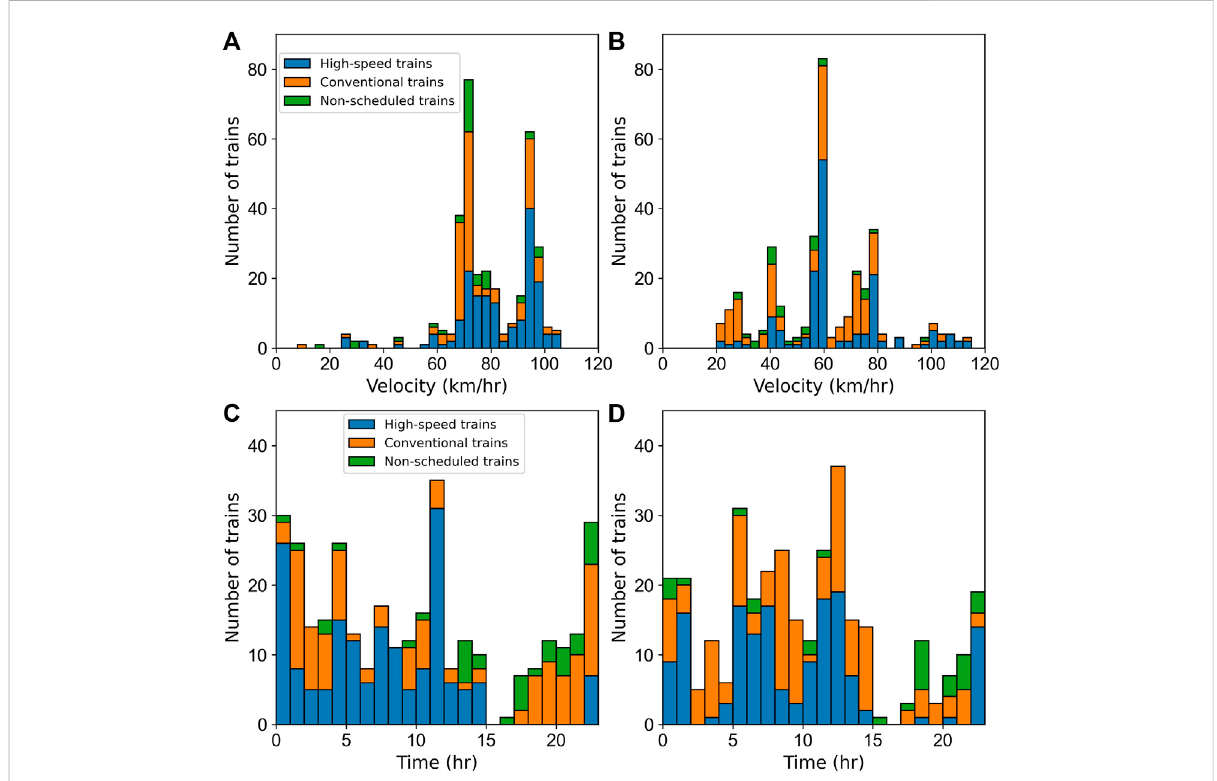
FIGURE 7 Histograms of speed distribution and hourly detections from N-S and S-N. (A,B) Speed distribution of all detected trains; (C,D) Hourly detections derived from the results shown in Figure